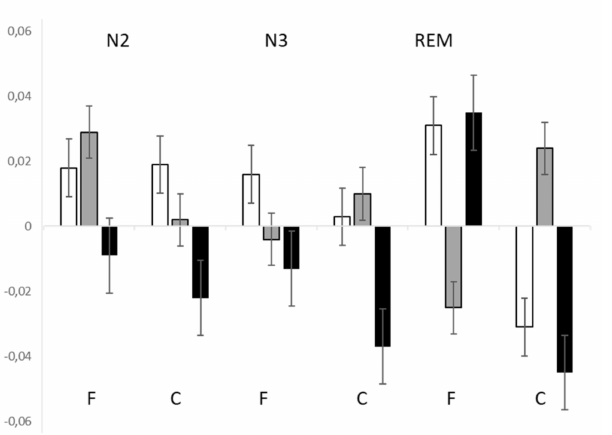
Figure 3. HEP amplitudes (mean, SD) in highs, mediums, and lows. White columns: highs; grey columns: mediums; black columns: lows. F: frontal sites C: central